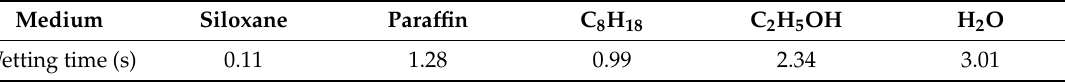
Table 2. The wetting time of different dyeing media on cellulosic film.